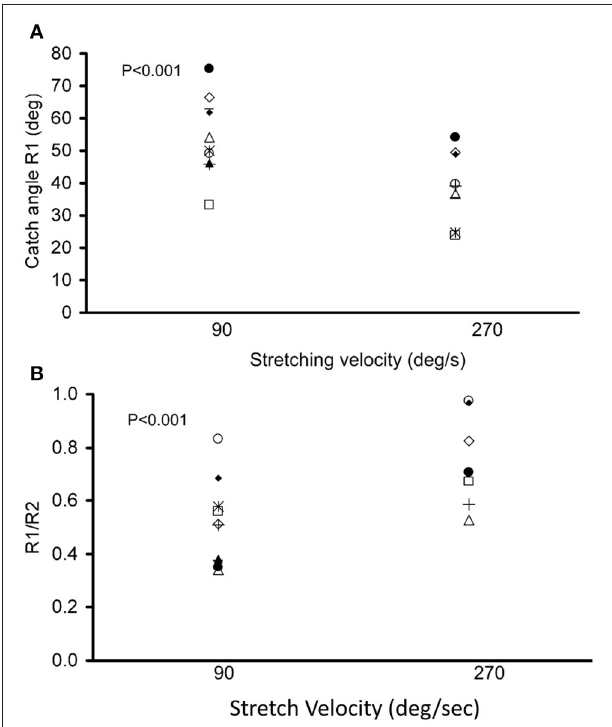
FIGURE 4 | Dependence of catch angle on the passive movement velocity. The catch angle (R1) and the ratio of the angular displacement between catch angle and initial flexion angle over ROM (R1/R2) with a controlled torque limit are shown in (A,B) , respectively. Each symbol represents a stroke survivor. Friedman test was used for multiple comparisons of catch angles at different stretch velocities with a significance level of p < 0.05.